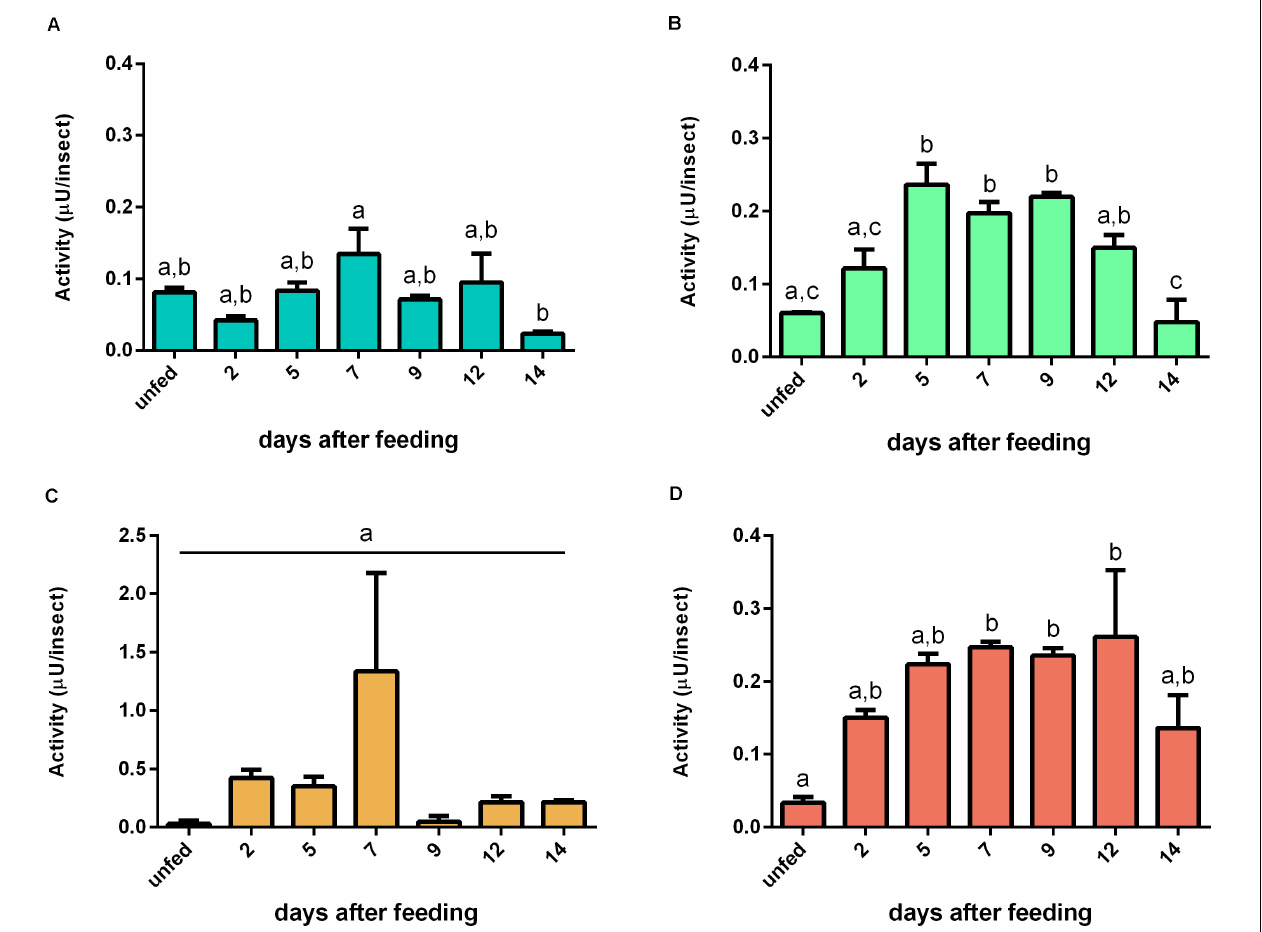
FIGURE 8 | The proteolytic pattern of activity per insect against bovine hemoglobin in the different digestive compartment tissues and luminal contents of Rhodnius prolixus male adults, unfed and at 2, 5, 7, 9, 12, and 14 daf on defibrinated rabbit blood, assayed in 0.2 M citrate-phosphate buffer, pH 5.5. (A) Anterior midgut tissues. (B) Posterior midgut tissues. (C) Anterior midgut contents. (D) Posterior midgut contents. Figures are means ± SEM from three different homogenate samples obtained from pools of two insects each. In a dataset, groups with the same superscript letter are not significantly different ( p > 0.05). Statistical